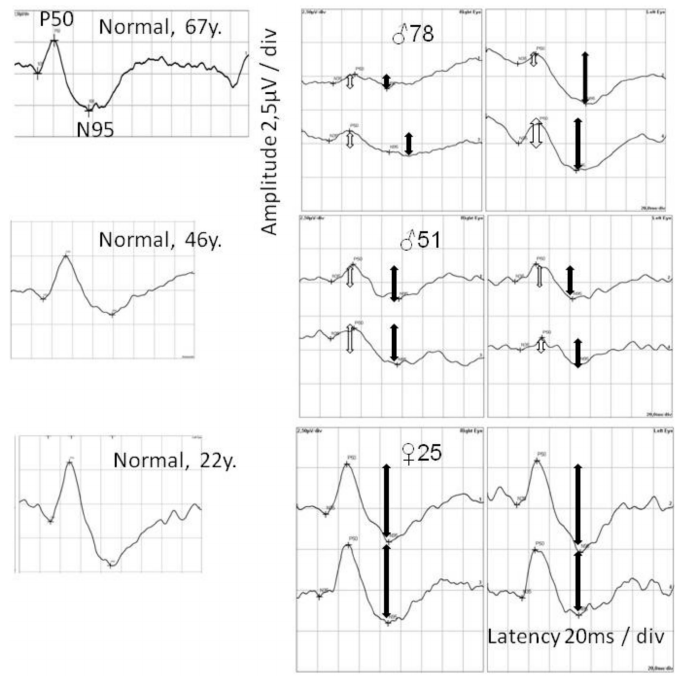
Figure 6. Pattern electroretinography (PERG) in the patients from three generations (proband, his son, and granddaughter—right figures) in comparison with results obtained from healthy men (left figures). Lower P50 wave amplitude in the proband and his son is marked with an empty arrow. Reduced N95 wave amplitude in all patients is marked with a filled arrow.